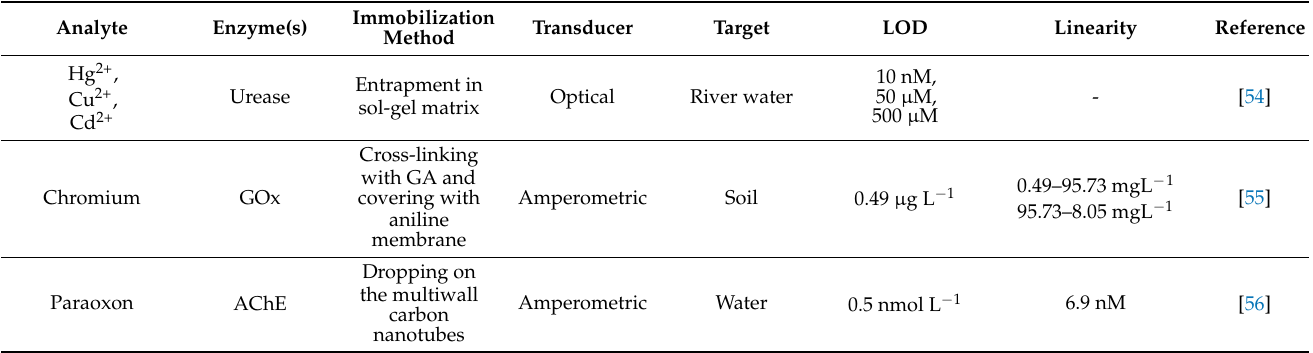
Table 2. Examples of enzyme-based biosensors used for environmental